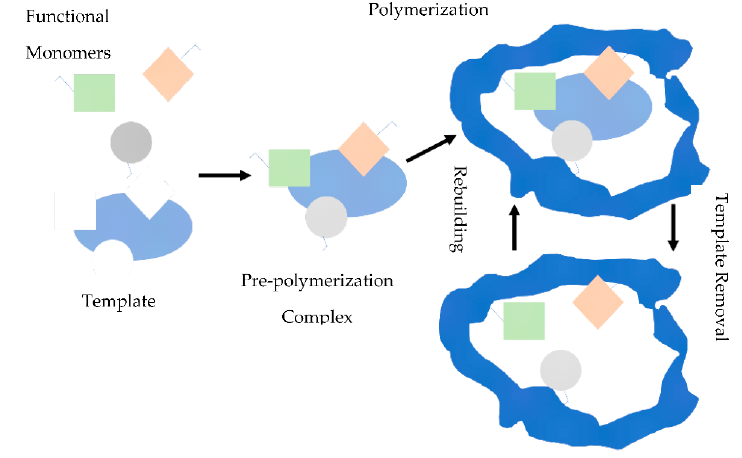
Figure 1. Molecular imprinting schematic illustration.